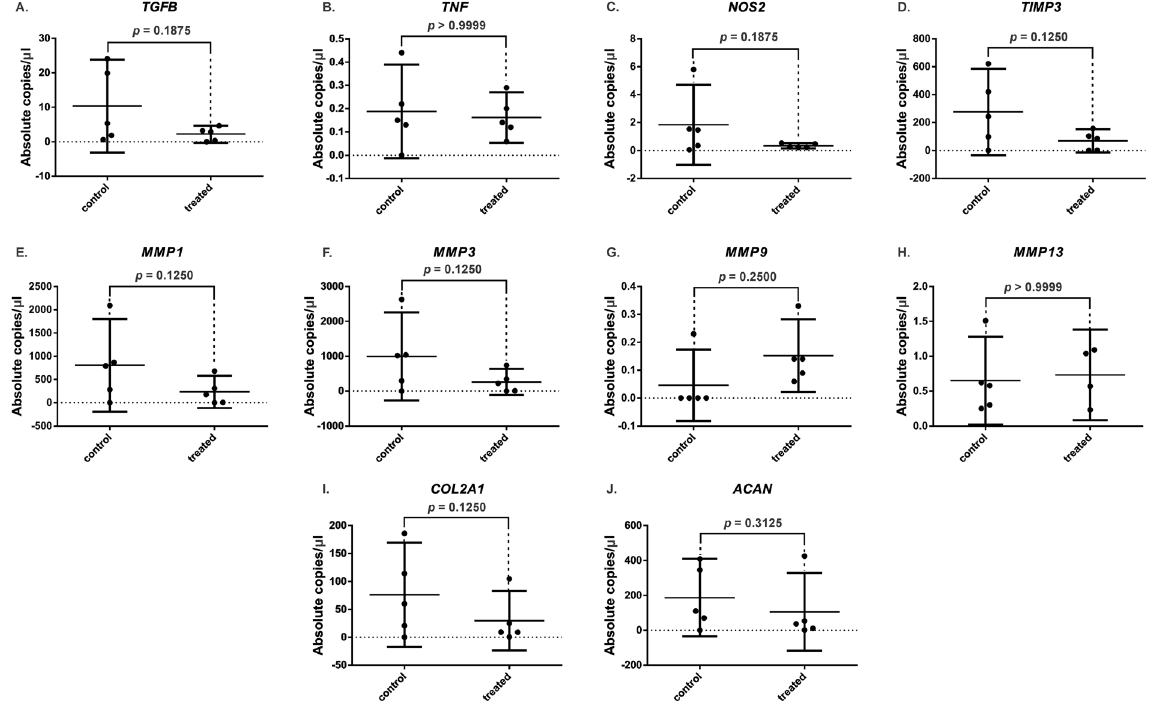
Figure 7. Effect of LU on the chondrocyte expression of catabolic, inflammatory and anabolic markers dysregulated in OA. Absolute copies concentration levels of corresponding genes per μ l of PCR reaction measured by digital PCR assay. Gene expression of the studied gene mRNA levels remained mostly unaltered under LU exposure ( p > 0.100, Wilcoxon) (individual biological replicates are shown ( n = 5 per group) as well as mean ± 95% confidence intervals; samples were measured as technical duplicates and averaged). The results indicate that interaction between LU pulses and chondrocyte may be a promising anti-catabolic approach to be further explored in the inflammatory management of